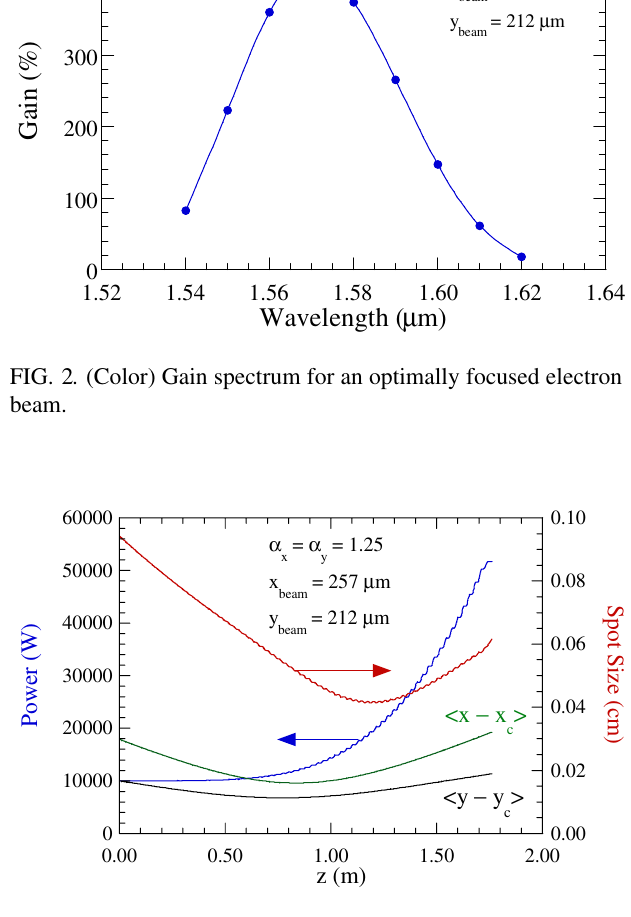
FIG. 3. (Color) Evolution of the power, optical spot size, and electron dimensions during a single pass through the wiggler.